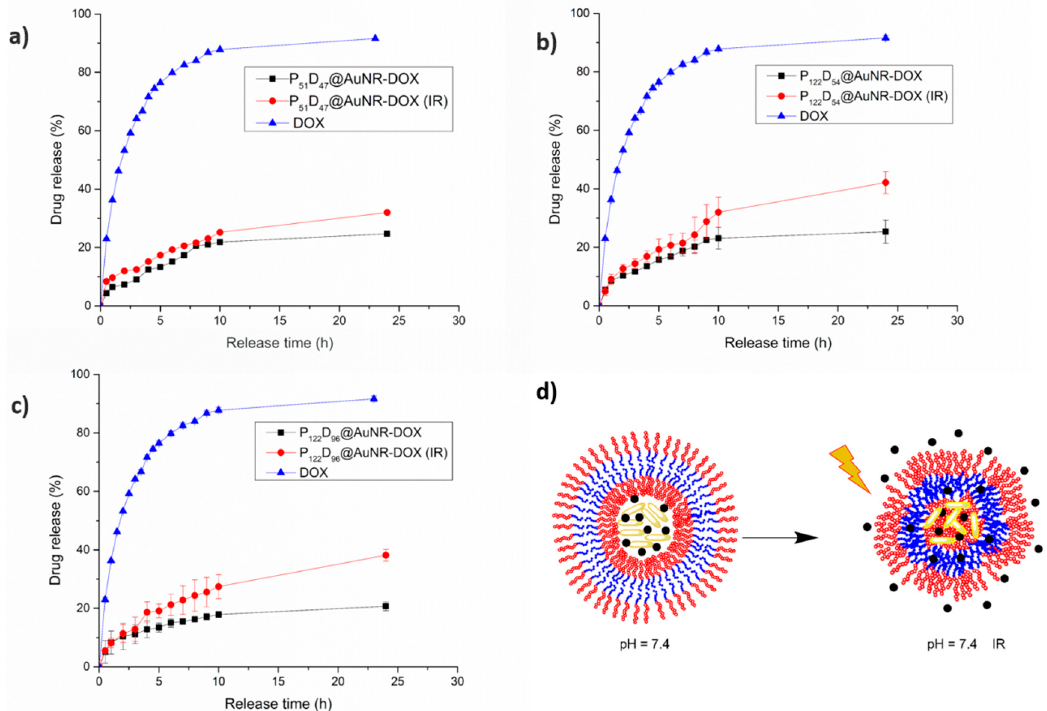
Figure 12. In vitro release profiles for DOX and AuNR-DOX-loaded polymersomes at pH 7.4. Effect of NIR irradiation: ( a ) P 51 D 47 polymersomes, ( b ) P 122 D 54 polymersomes, and ( c ) P 122 D 96 polymersomes. ( d ) Model of polymersomes behavior.